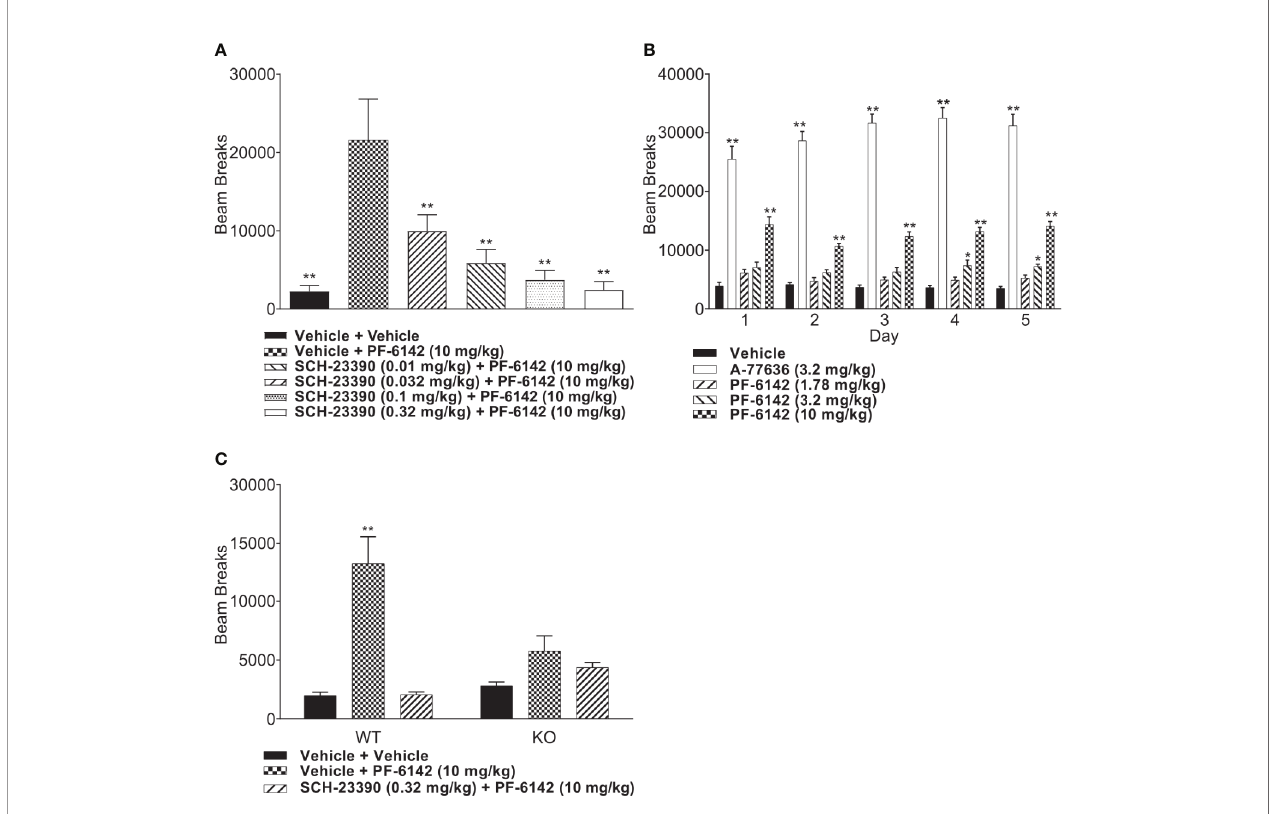
FIGURE 2 | Mouse locomotor activity (LMA) following administration of PF-6142. (A) Treatment with PF-6142 increases the number of beam breaks and pretreatment with the D1 antagonist, SCH-23390, effectively and dose dependently blocks the hyperactivity induced by PF-6142. (B) Daily administration of D1 agonists. (C) The hyperactive response is greatly diminished in the D1 KO mice compared to WT mice. Data are shown as the mean beam breaks + SEM. N = 8. One-way ANOVA with Dunnett ’ s post-test adjusted *p < 0.05, **p < 0.01 vehicle + PF-6142 (10 mg/kg) (A) . Two-way ANOVA with Dunnett ’ s (B) or Tukey ’ s (C) post-test adjusted *p < 0.05, **p < 0.01 vs vehicle (B) or vehicle + vehicle (C)